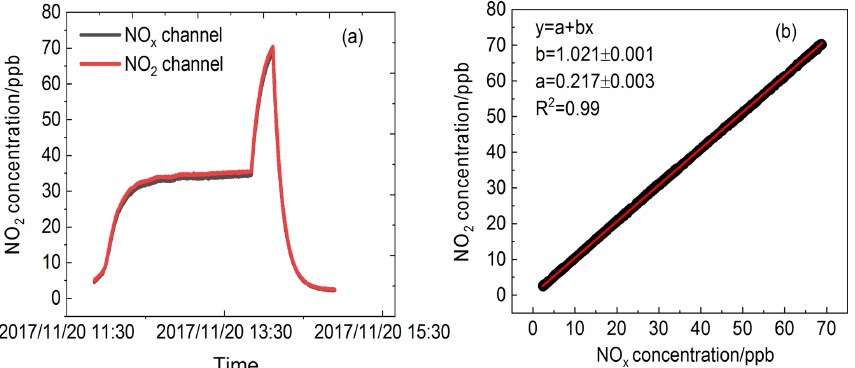
Figure 6. (a) Time series of NO 2 concentration standard mixtures sampled by the CRDS instrument in two channels with mercury pen-ray lamp switched on. (b) A correlation plot between the data from two channels.